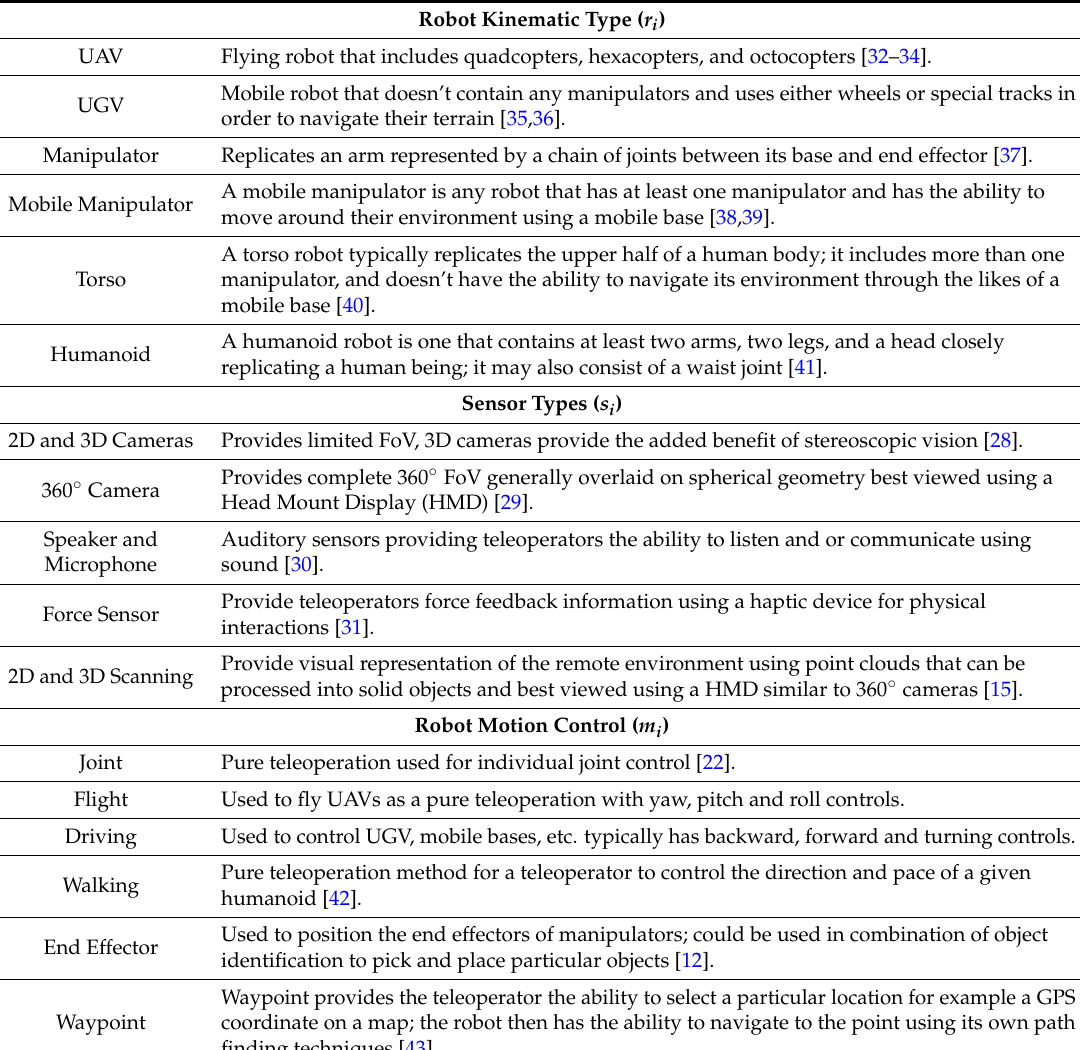
Table 1. Definitions defining the robot characteristics used in the Matlab